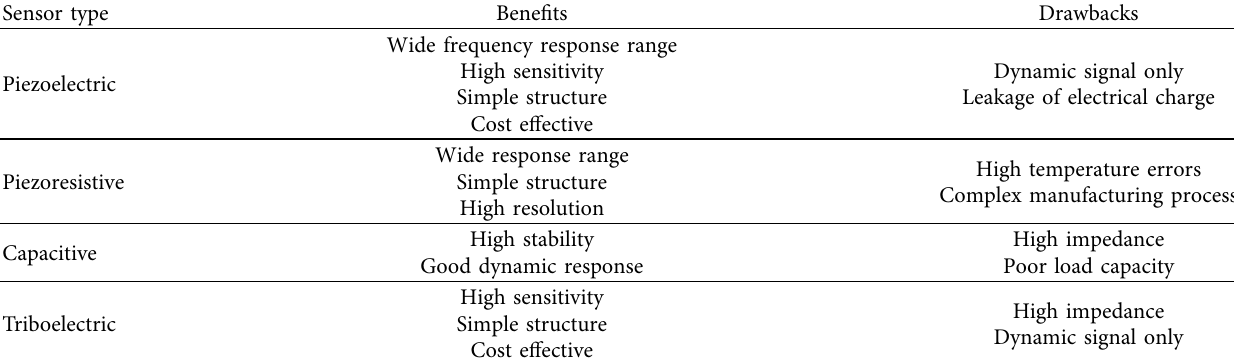
Table 4: Benefts and drawbacks of piezoelectric, piezoresistive, and capacitive triboelectric sensors. Sensor